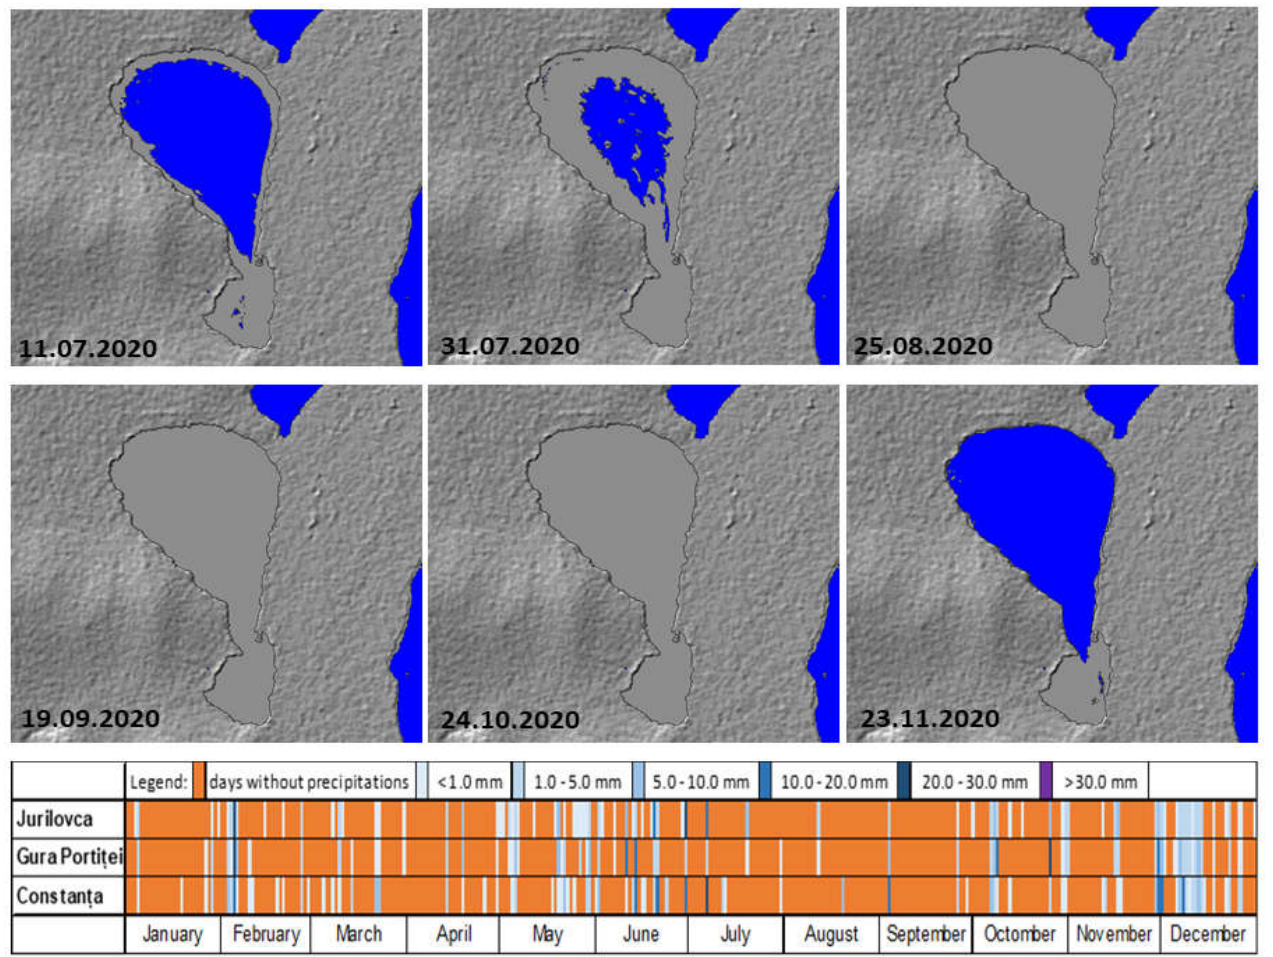
Figure 6. WS in 2020 (Sentinel-2) ( above ); Days with representative precipitation amounts at Jurilovca, Gura Portiței and Constanța weather stations in 2020 ( below ).